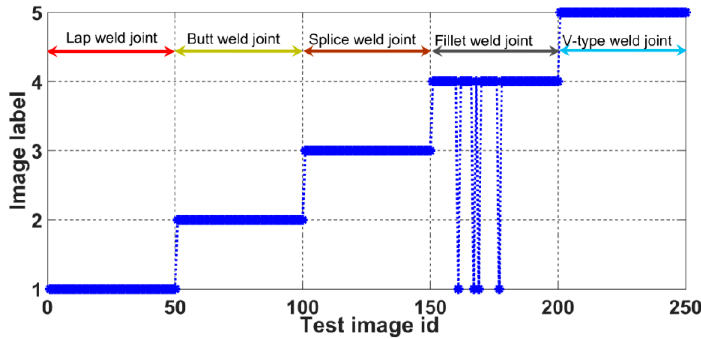
Figure 18. Results of weld joint identification using the proposed method.